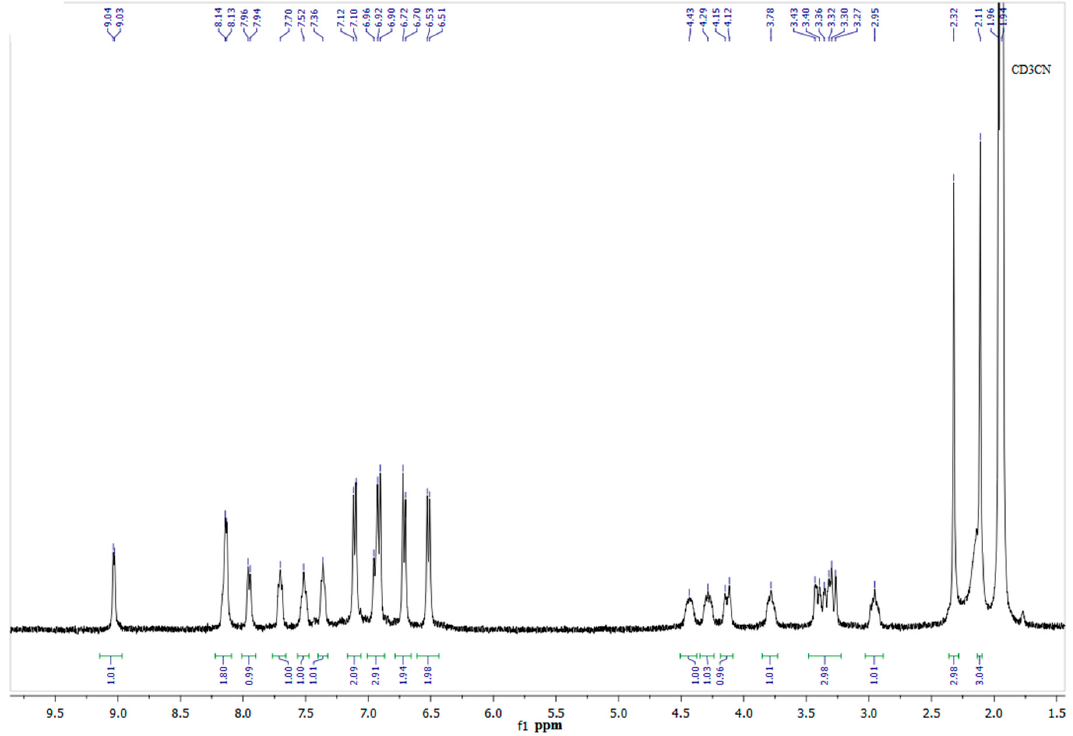
Figure 1. The 1 H-NMR spectrum of complex 9 in CD 3 CN (400 MHz).